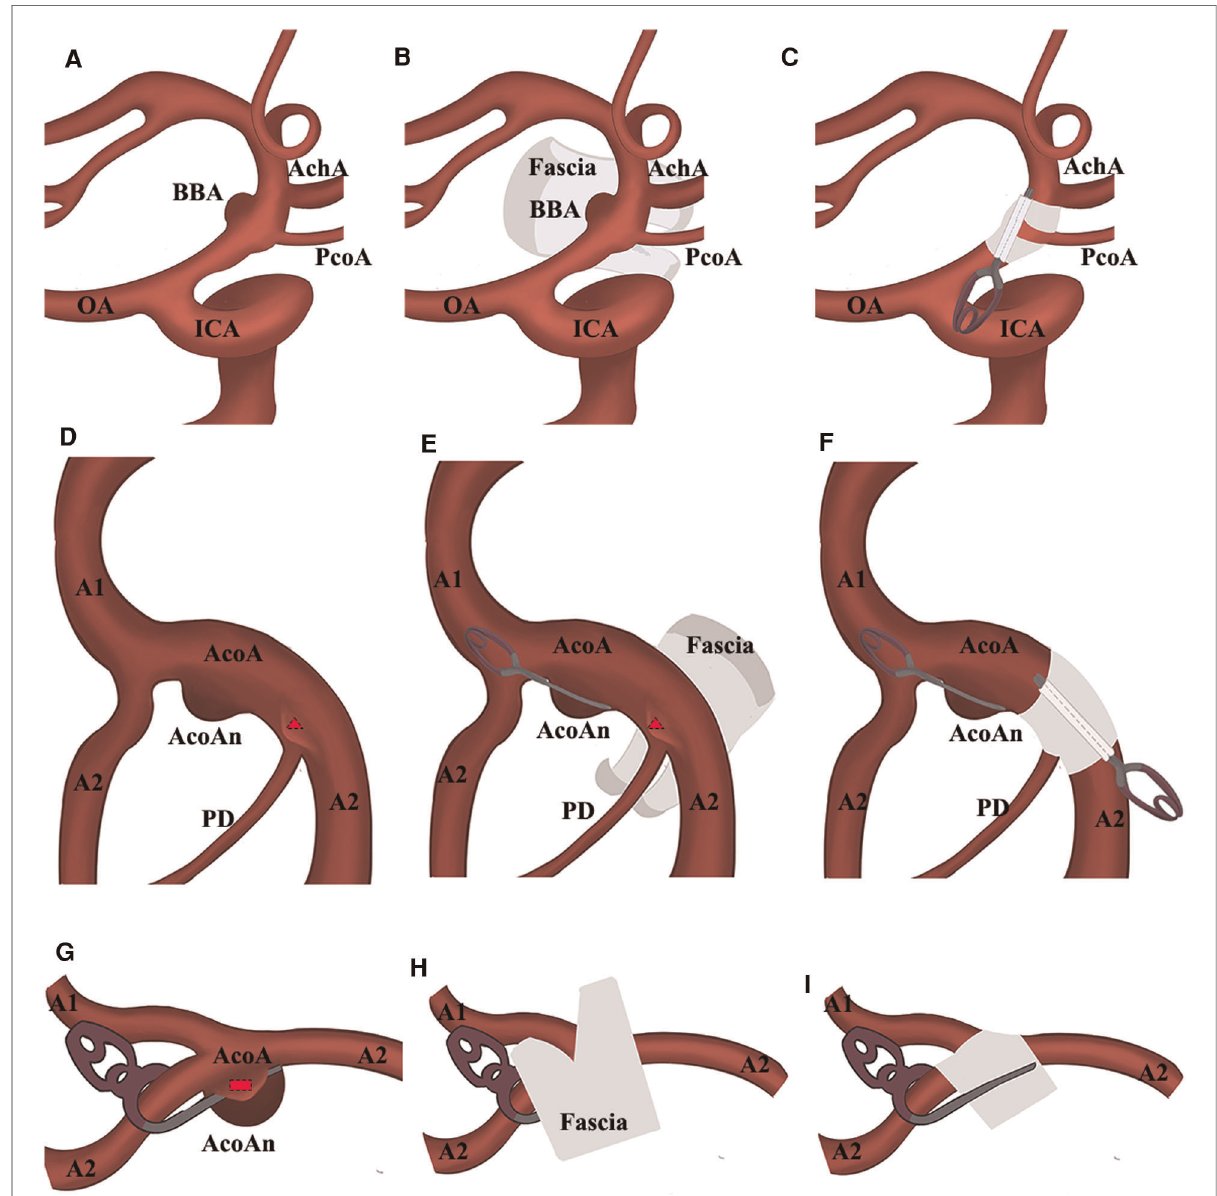
FIGURE 2 Schematic presentation. ( A ) BBA located at the supraclinoid segment of ICA; ( B ) Y-shaped temporalis fascia wrapped the BBA; ( C ) PcoA crossed through the gap of the fascia and aneurysm was disappeared; ( D ) multiple acoAns; red triangle means the microaneurysm near the ipsilateral A2; ( E ) AcoAn was simply clipped and microaneurysm was wrapped by the Y-shaped temporalis fascia; ( F ) AcoAn was simply clipped and microaneurysm was disappeared; ( G ) remnant of large AcoAn treated by the simply clipping was presented as a red rectangle; ( H ) fascia wrapped the aneurysm and A1 crossed through the gap; ( I ) AcoAn was disappeared. AchA, anterior choroidal artery; AcoA, anterior communicating artery; AcoAn, anterior communicating artery aneurysm; BBA, blood blister-like aneurysm; CRYST, clip-reinforced wrapping using Y-shaped temporalis fascia; ICA, internal cerebral artery; OA, ophthalmic artery; PcoA, posterior communicating artery; PD, perforating